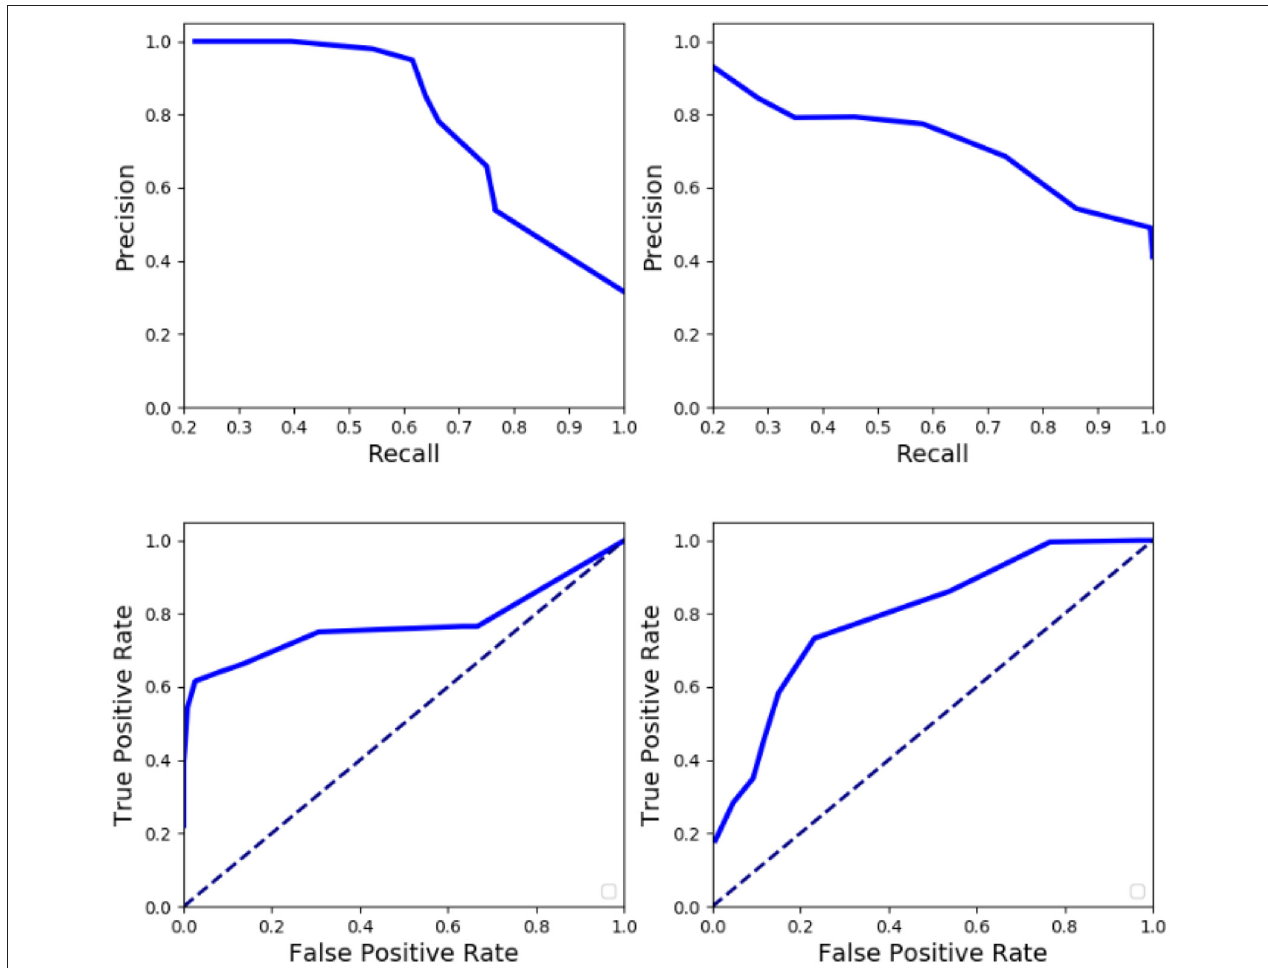
FIGURE 7 | Quantitative analysis of anomaly network in terms of recall, precision, and ROC averaged over various anomalous activities ( Left : Falling, GetUp, and Jumping anomalies; Right : Kicking, Picking, and Sitting anomalies). The difficult anomalies have been grouped together based on their level of overlap with normal activity.